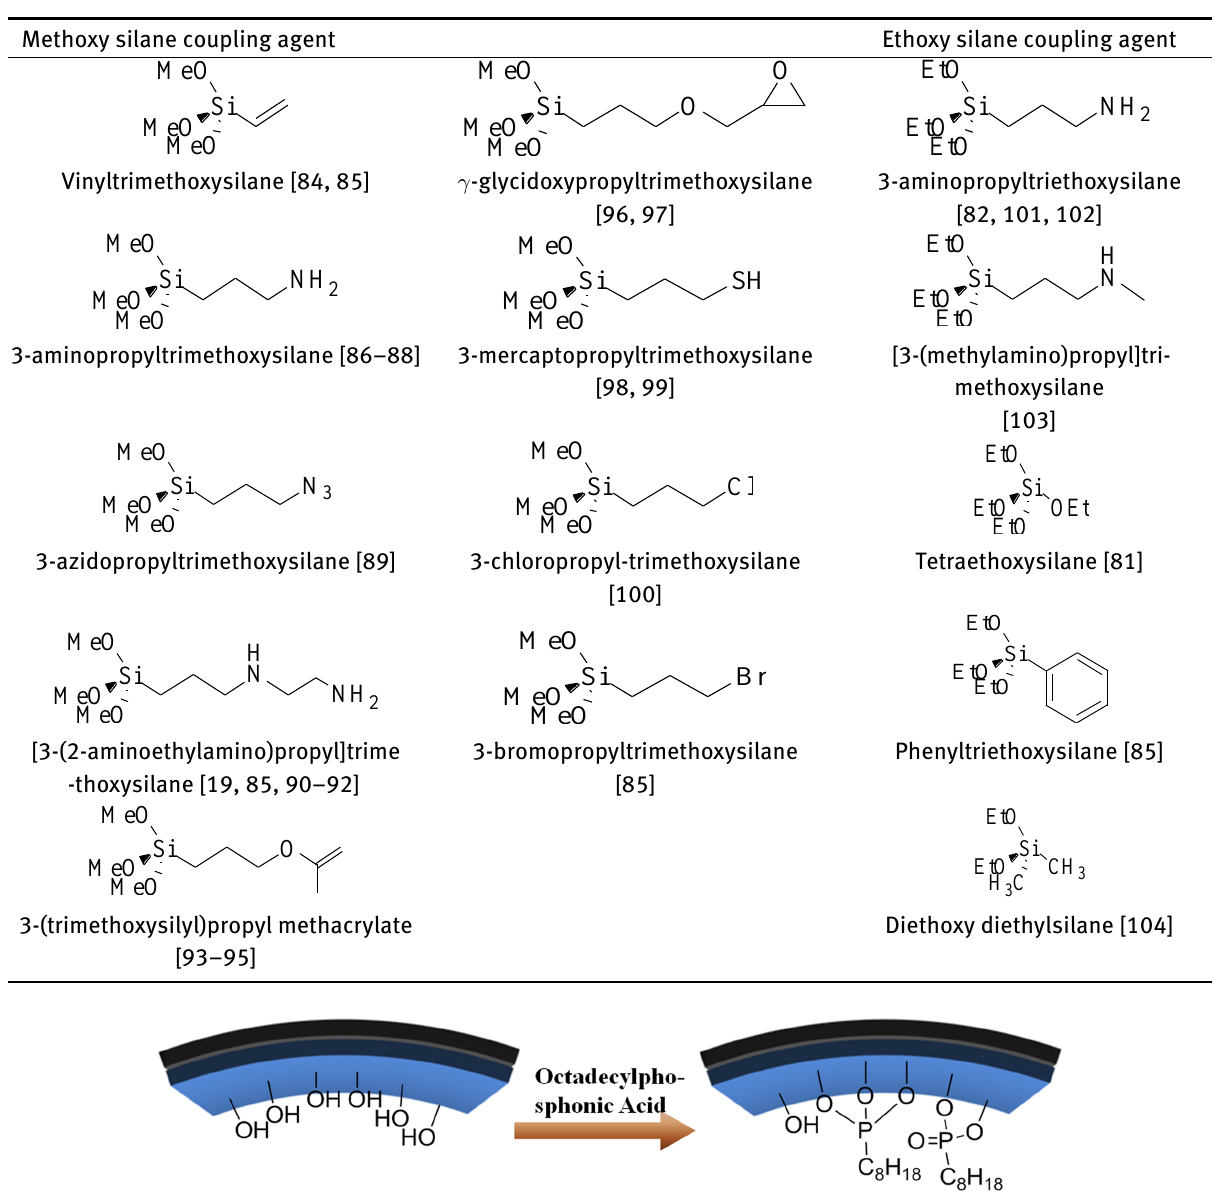
Table 2: The chemical composition of silanes used for modification of HNTs [83] Methoxy silane coupling agent Ethoxy silane coupling agent